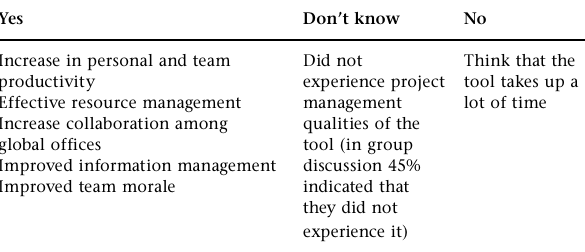
Table 14 sets out the reasons provided by project team members. Figure 2 refers to responses of project managers and